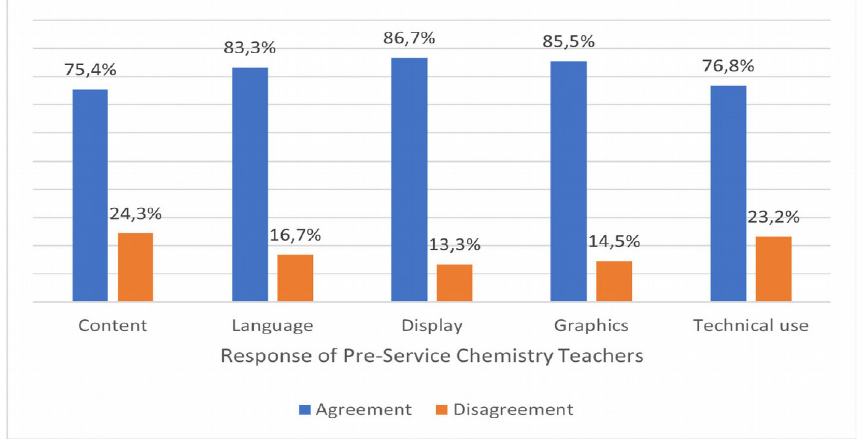
Figure 4. The Result of Response in Cycle